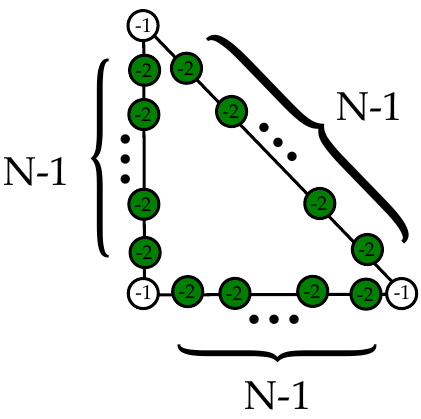
Figure 6 . CFD for the T N theory. The ( (cid:0) 2)-curves are the marked vertices from which the SU( N ) 3 (cid:13)avor symmetry can be read o(cid:11). The ( (cid:0) 1) curves correspond to unmarked vertices in the CFD, which are the starting points for